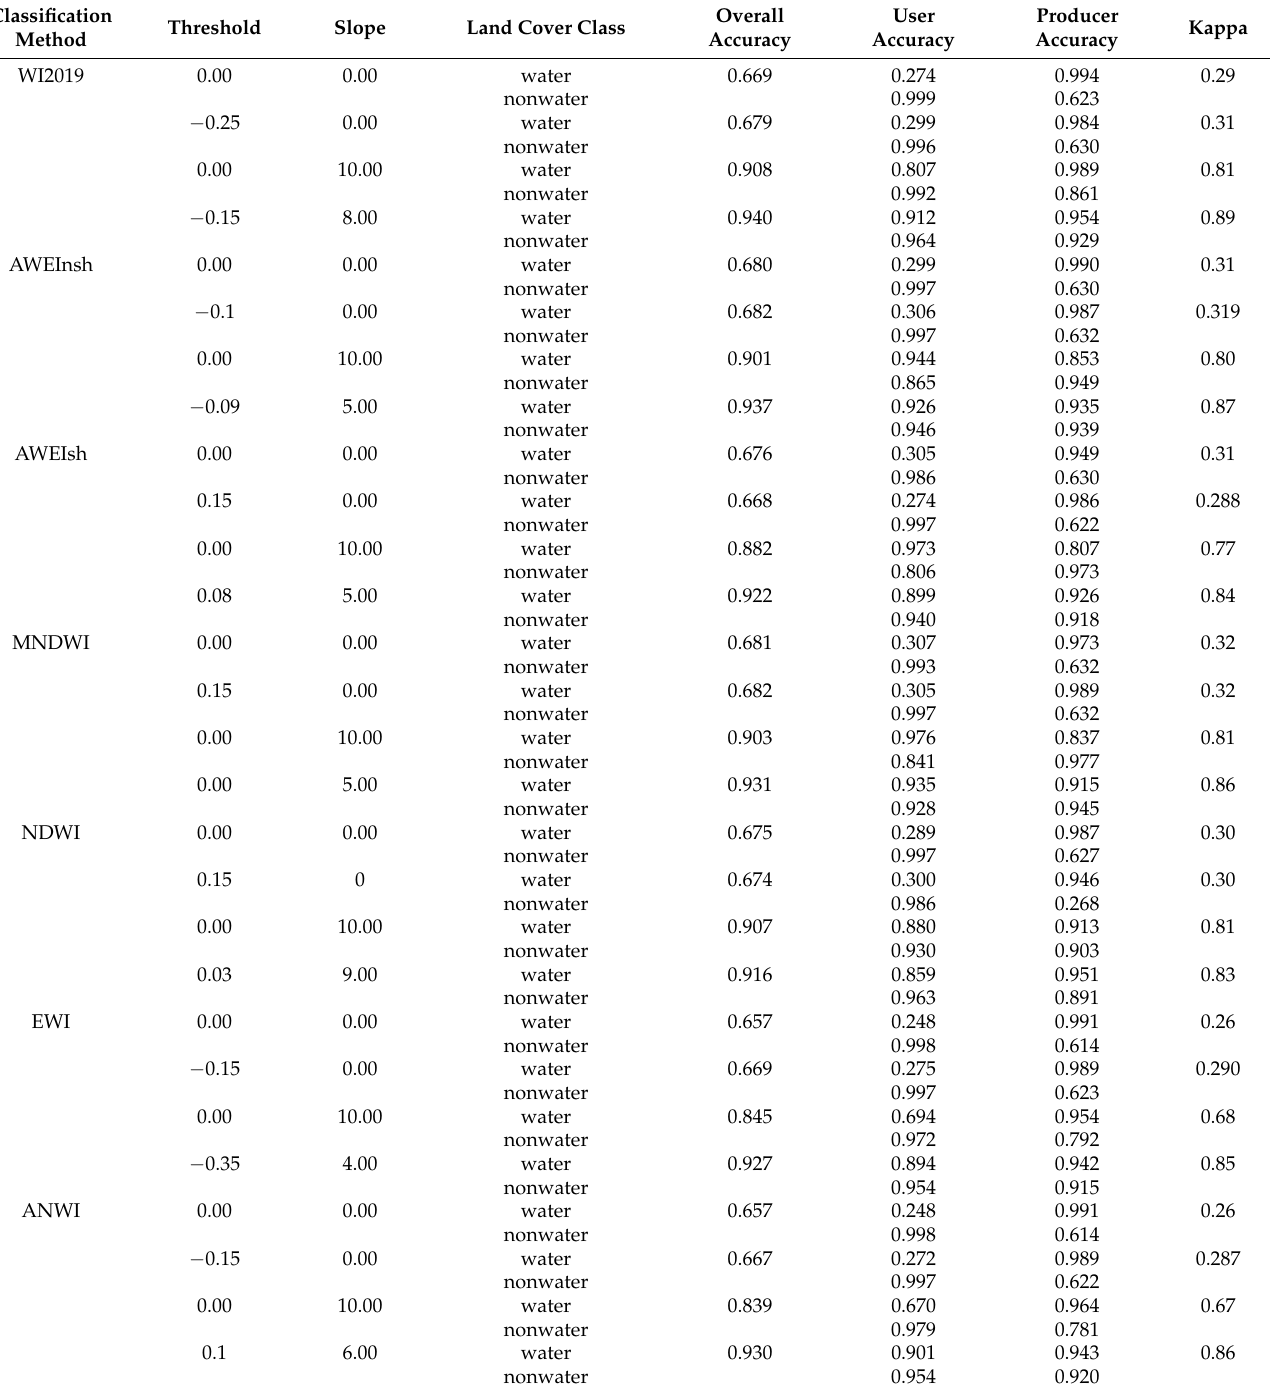
Table 2. Evaluation table of accuracy of water extraction results of different